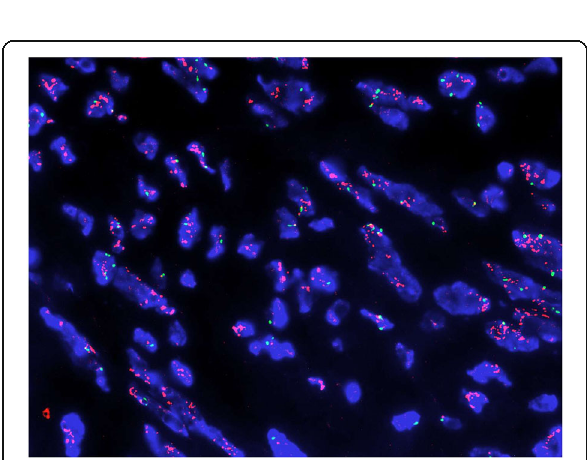
Fig. 4 Fluorescence in situ hybridization of vaginal dedifferentiated liposarcoma. The assessment of MDM2 gene amplification by fluorescence in situ hybridization is a highly useful adjunctive diagnostic tool in the diagnosis of dedifferentiated liposarcoma. Red signals represent MDM2, and green signals represent chromosome 12